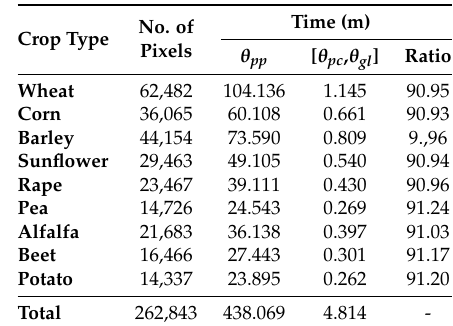
Table 6. Processing time (minutes) using the standard per-pixel hyperparameters optimization